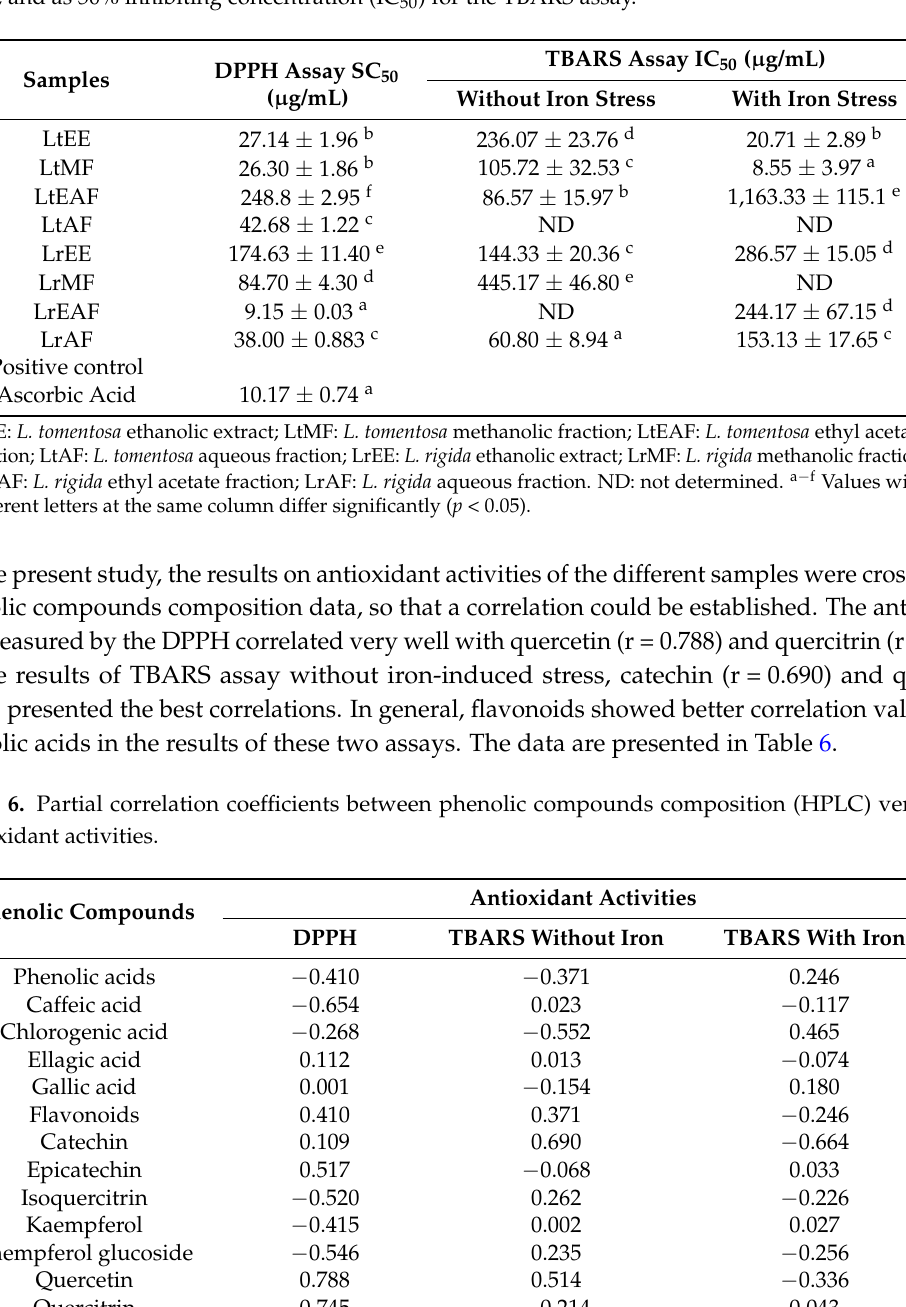
Table 5. Antioxidant activities of Licania tomentosa and L. rigida seed extracts and fractions. The scavenging activities were expressed as 50% scavenging concentration (SC 50 ) for the DPPH assay, and as 50% inhibiting concentration (IC 50 ) for the TBARS assay.